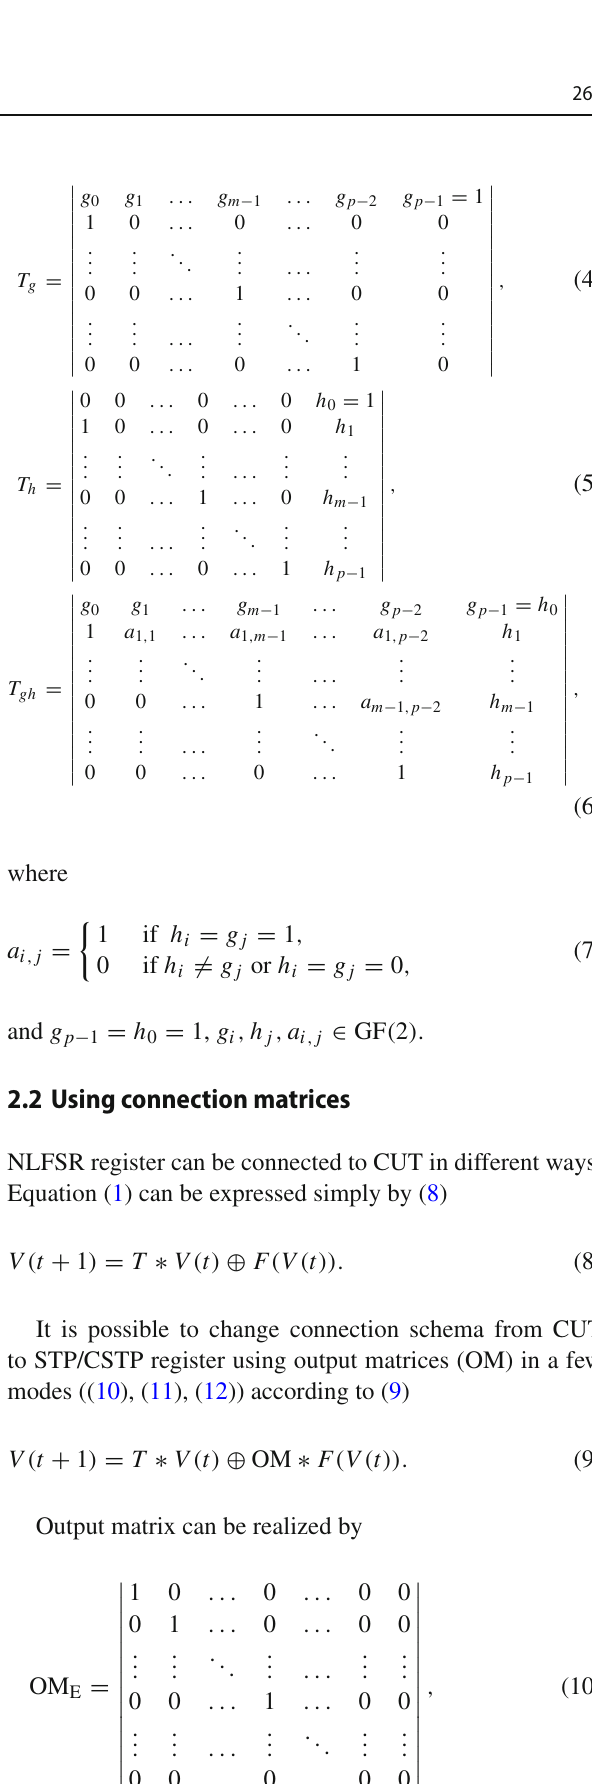
forms: external, Top-Feedback ExOR (4) (Fig. 3), internal, Bottom-Feedback ExOR (5) (Fig. 4) and external–internal, Top–Bottom-Feedback ExOR (6) (Fig.